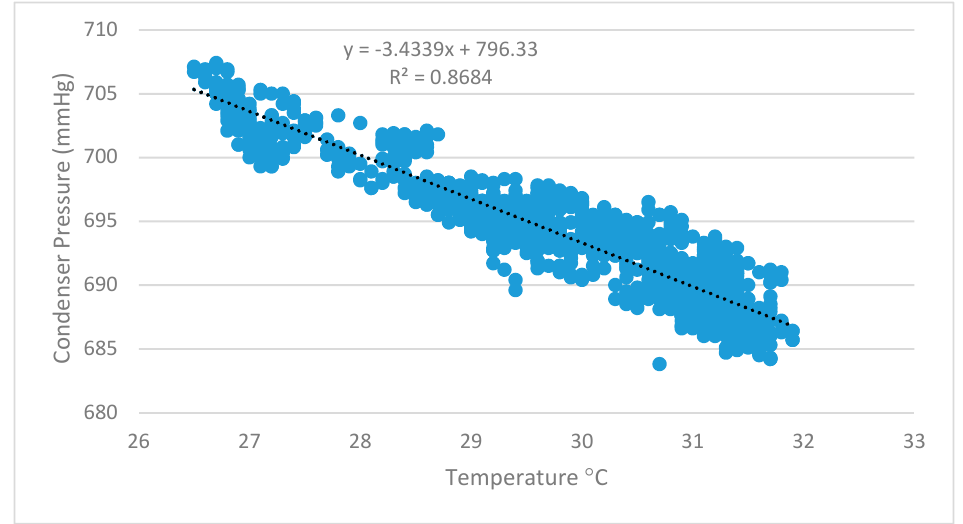
Figure 4. The condenser vacuum as a function of cooling water temperature: PJB Paiton CFPP, half-hourly, December 2015 (1409 data points). Source: own fieldwork.